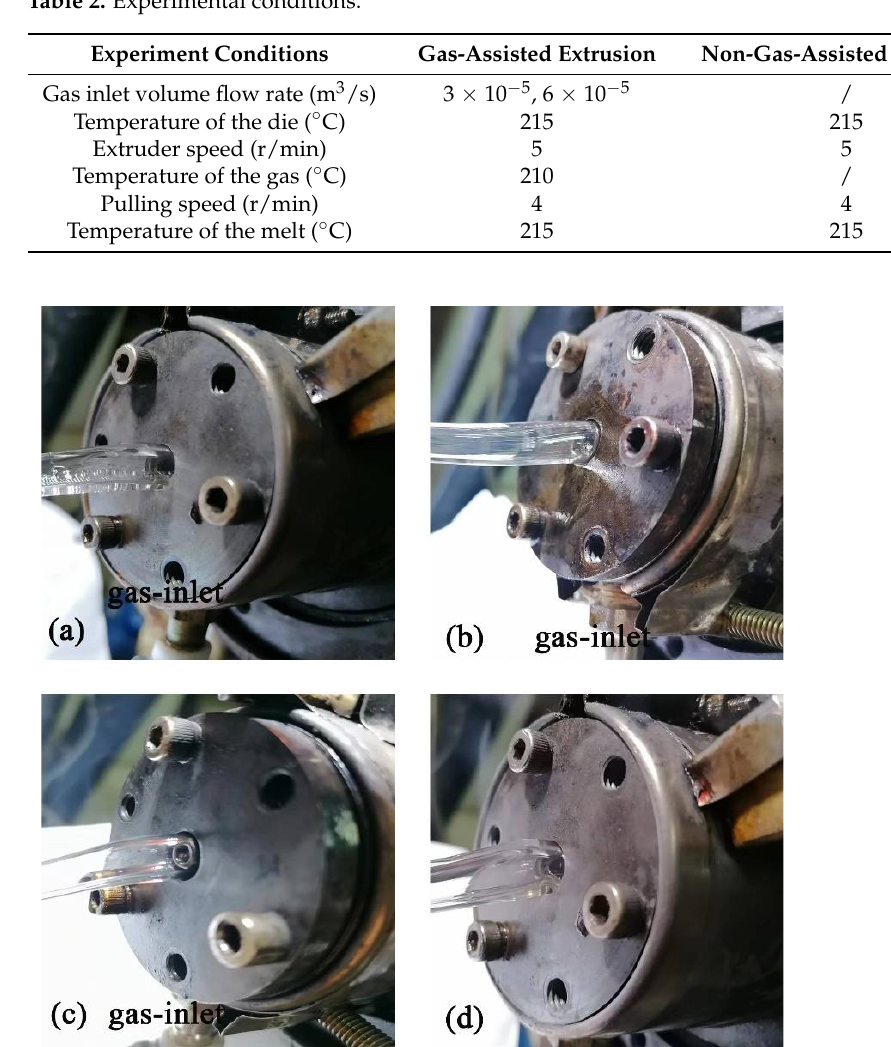
Figure 11. Results of extrusion experiment. ( a ) Gas inlet volume flow rate of 3 × 10 −5 m 3 /s for the single gas chamber die; ( b ) Gas inlet volume flow rate of 3 × 10 −5 m 3 /s for the double gas chamber die; ( c ) Gas inlet volume flow rate of 6 × 10 −5 m 3 /s for the double gas chamber die; ( d ) Non-gas-assisted extrusion.